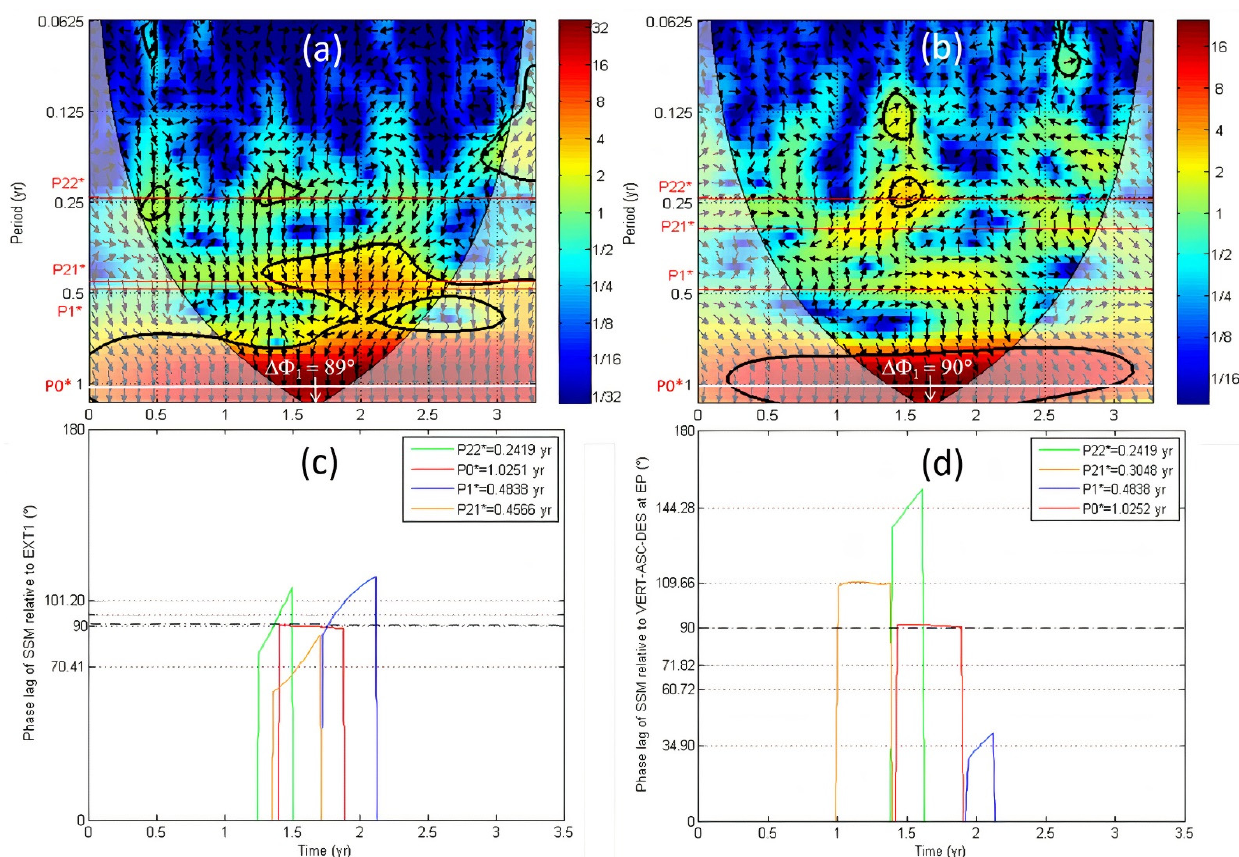
Figure 9. In the top, the cross wavelet transform (XWT) between SSM-ASC using SMOS ascending track and two times series is shown: ( a ) EXT1 and ( b ) VERT-ASC-DES at East Point (EP). The relative phase relationship is shown as arrows, with in-phase pointing right and anti-phase pointing left and the Surface Soil Moisture leading by 90° pointing straight down. The Cone of Influence (COI) where edge effects might distort the picture is shown as a lighter shadow. In the bottom, the phase lags ΔΦ of SSM-ASC relative to the same times series are shown: ( c ) EXT1 and ( d ) VERT-ASC-DES at EP. The shrinking (P1*) and swelling (P21* and P22*) periods are found using the thick contours of XWT that designate the 5% significant level against red noise (see Materials and Methods section). Table 2. Comparison of Fourier FFT and cross-wavelet XWT analysis of phase angles and time lags of the surface soil moisture (SSM-ASC) relative to the vertical displacement at EXT1, EXT2, West Point (WP), and East Point (EP) for P0, P1, P21, and P22 periods.